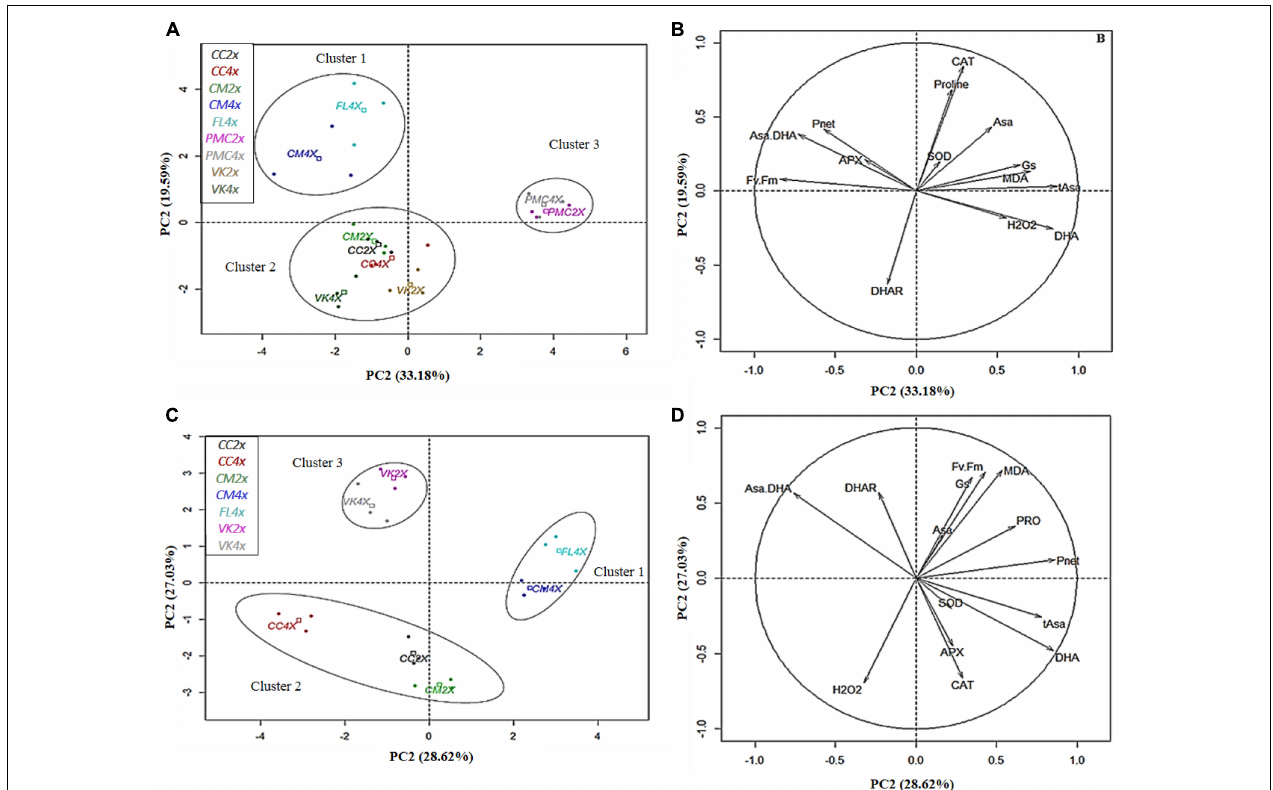
FIGURE 4 | Biplot obtained from PCA performed after (A,B) 210 days of total nutrient deficiency and 30 days of recovery (C,D) in leaves of the nine genotypes. (A,C) dispersion of genotypes and (B,D) contribution of the variables to the dispersion. The variables analyzed are net photosynthesis rate ( P net ), stomatal conductance ( G s ), chlorophyll fluorescence ( F v / F m ), malondialdehyde (MDA), hydrogen peroxide (H 2 O 2 ), antioxidant enzymes (SOD, CAT, APX, and DHAR), reduced ascorbate (Asa), oxidized ascorbate (DHA), total ascorbate (tAsa), ascorbate redox status (Asa/DHA), and proline.